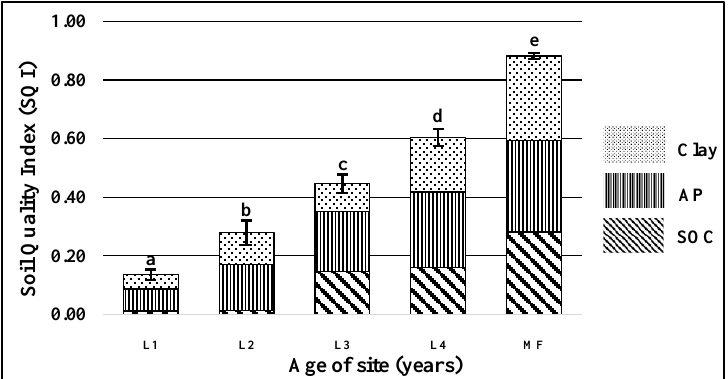
Figure 6. Mean soil quality index (SQI) values in landslide disturbed sites (L 6 , L 16 , L 21 and L 26 ) and reference site (MF — mature forest) with standard error bars (±S.E.) of total index values having significant difference at p < 0.05. AP- Available phosphorus; SOC- Soil organic carbon.